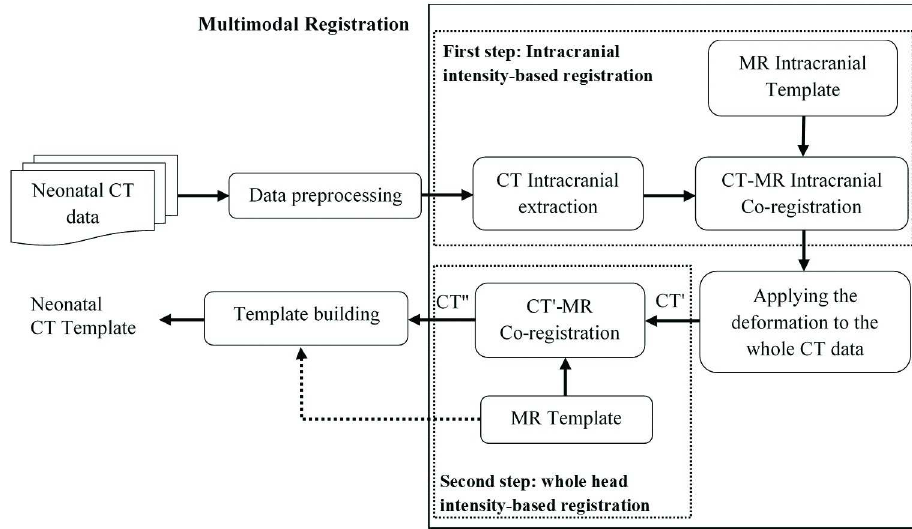
Fig 1. Flow diagram of the proposed pipeline to construct the CT